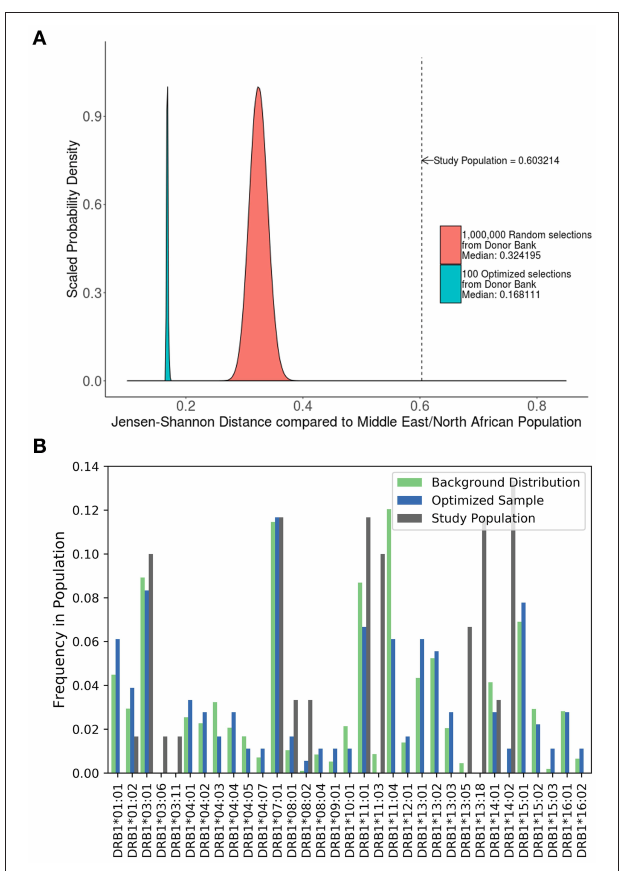
FIGURE 6 | Optimizing a cohort with donors from a different sub-population as the population of interest. (A) A similar analysis was performed on the 90 HLA typed subjects who formed the control group of a study on the relationship between HLA-DRB1 type and psoriasis in Iraq. The control population being analyzed was not randomly selected and as such is very different from a background distribution of Middle Easterners/North Africans Donors in the United States. In addition, 1,000,000 million randomly selected samples from a North American cohort of were selected and compared to this same background distribution (red). One hundred optimized samples created from these available North American samples (green) were much closer to the target Middle Eastern/North African population even though they were chosen from a group of general North American Donors. (B) The distribution of alleles one of the optimized sample (blue) is much closer to the target background distribution (green) than the control group in the study